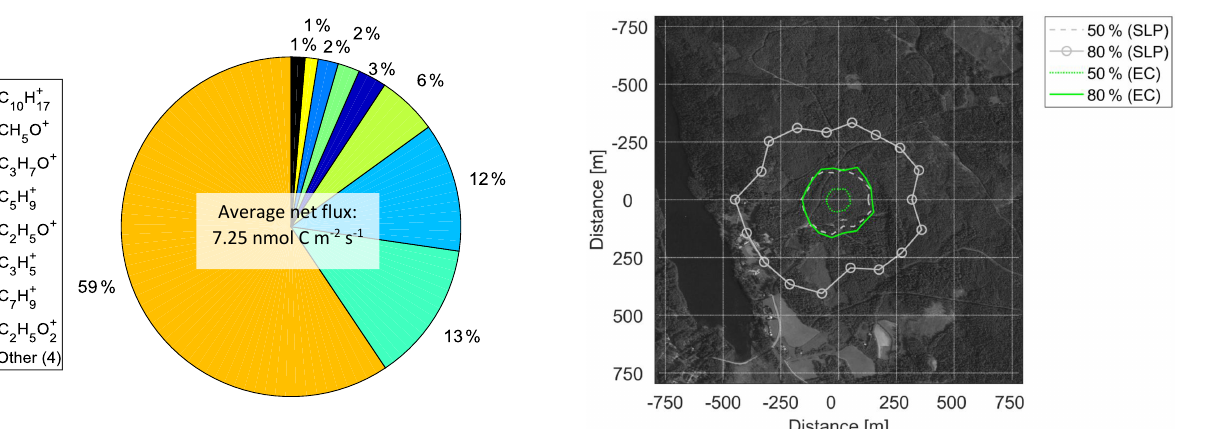
Figure 7. Average net flux of the major carbon emitters (June). Compounds whose elemental composition could not be identified were disregarded. See Table 1 for the corresponding compound names. The butene + butanol emissions were disregarded in this fig- ure.